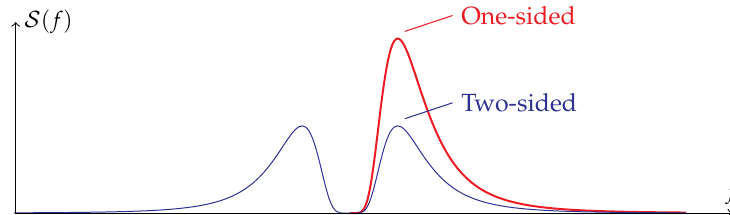
Figure 1. Illustration of the one-sided and two-sided representation of the same